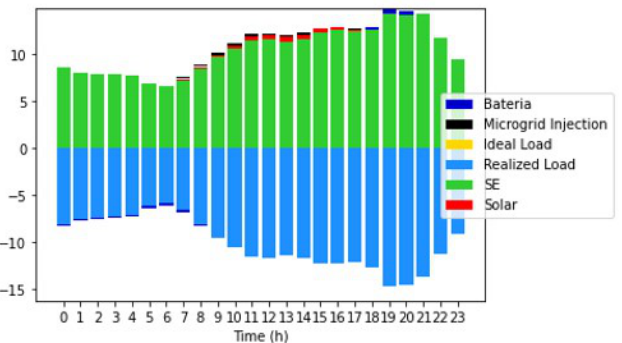
Figure 16. Active power balance of the point of view of the substation for the case with active distribution network and with increased